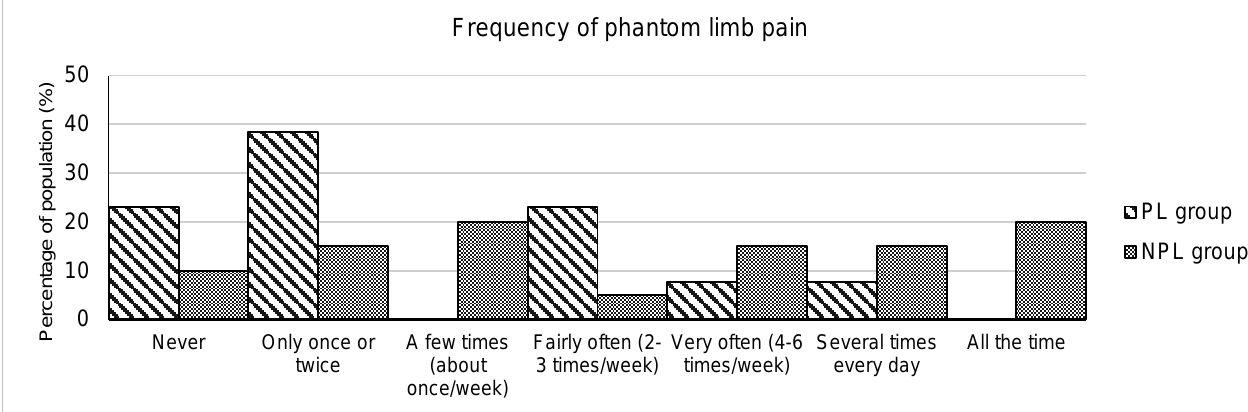
Figure 4: PEQ pain subset results for the frequency of phantom limb pain experienced by both PL (striped) and NPL (grey) groups. A skew to the left indicates less pain. The difference between groups was significant (p<0.05) with PL users experiencing less